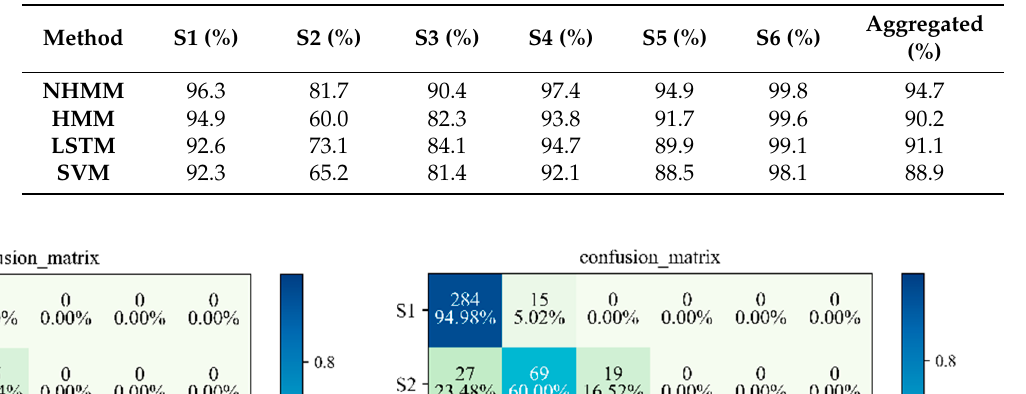
Table 3. 8-fold cross validation recognition results of four classifiers (S1–S6 correspond to RHS, RFF, RFS, LHS, LFF, and LFS, respectively).